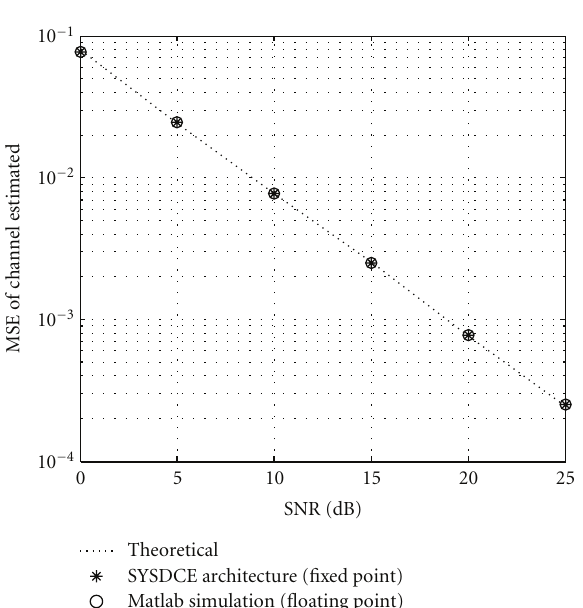
Figure 14: MSE performance of the SYSDCE hardware for 300 Monte Carlo trials.